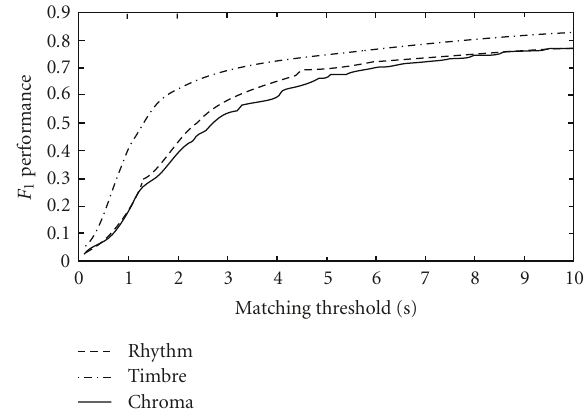
Figure 6: Mean of F 1 performance as a function of the matching threshold for 49 songs.